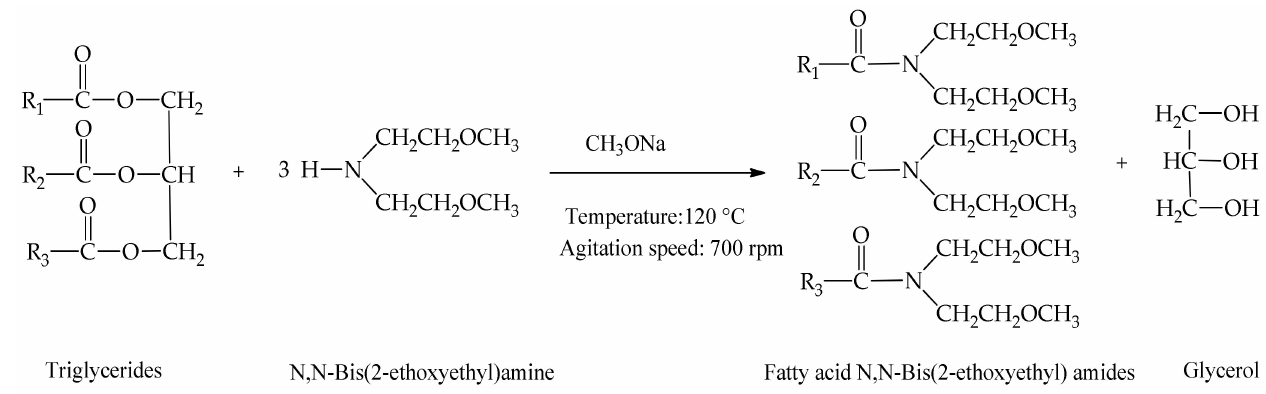
Figure 1. General reaction scheme for the synthesis of fatty acid N , N -Bis(2-ethoxyethyl)